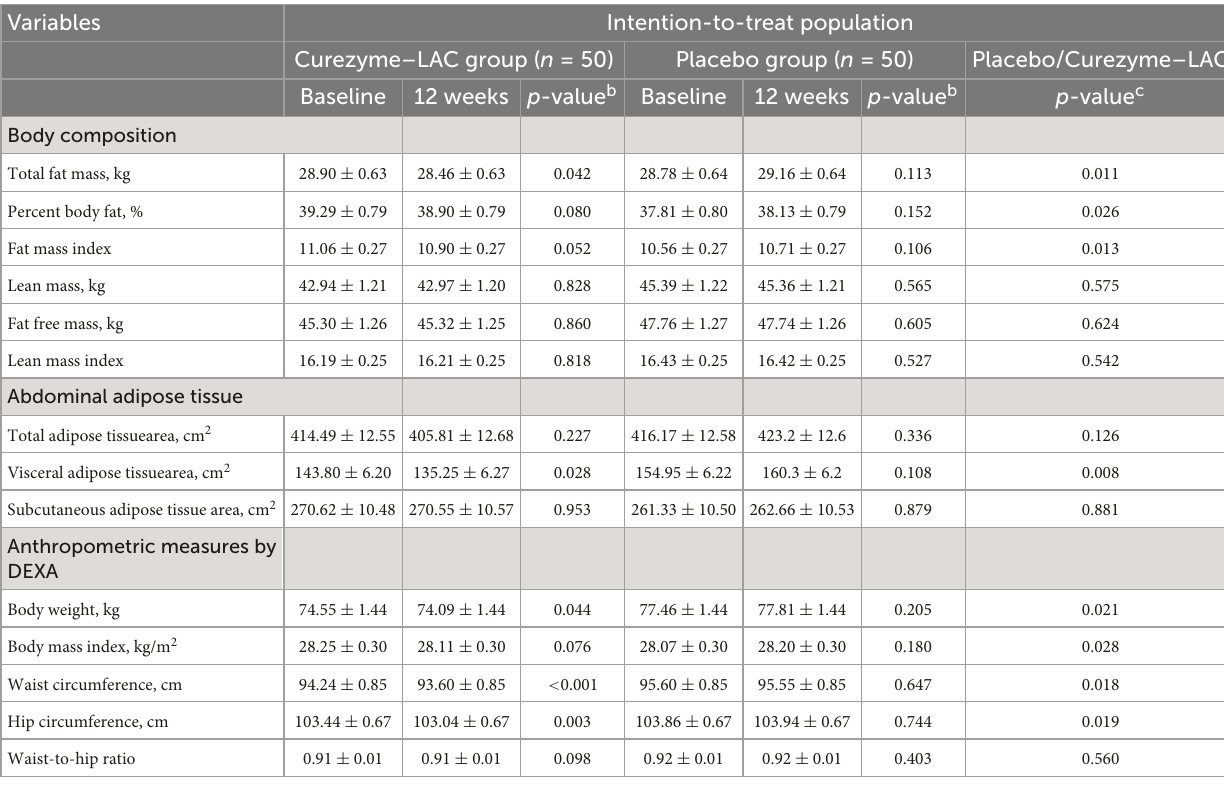
TABLE 2 Body composition, abdominal adipose tissue, and anthropometric measurements a .